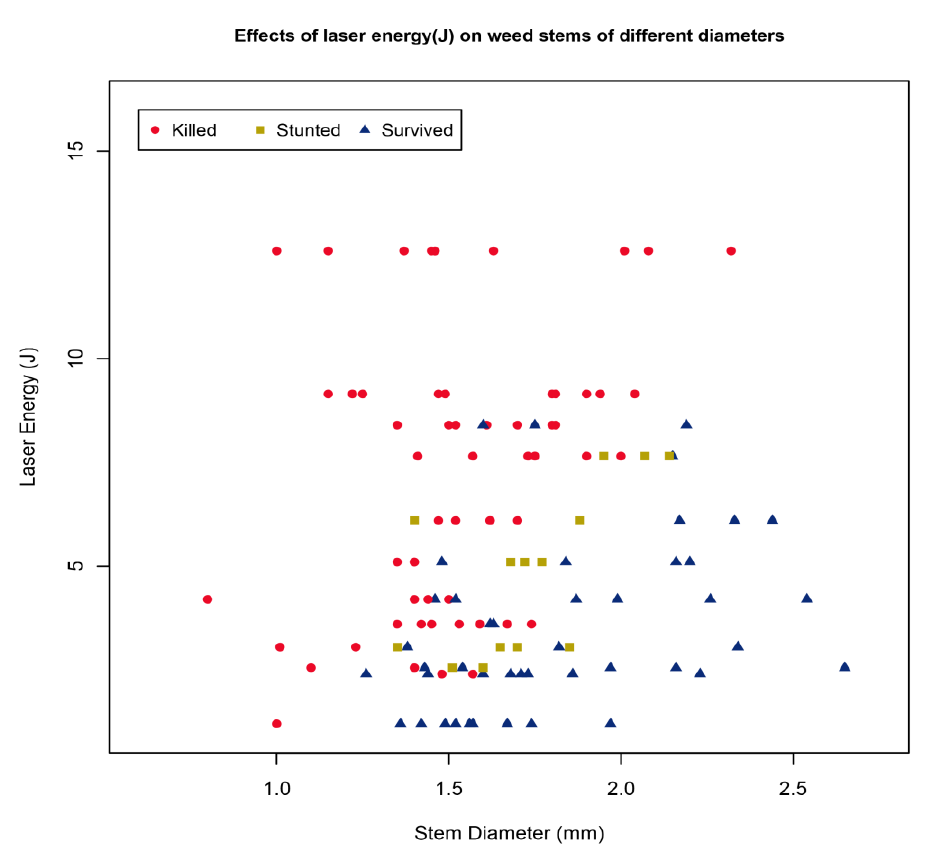
Figure 10. Effects of laser energy (power × treatment time) on weed stems of different